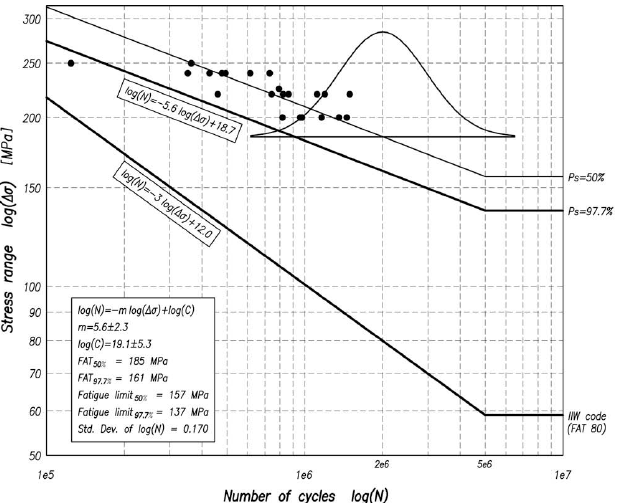
Figure 12. Experimental and design S–N curves [30]. Reprinted with permission from ref. [30]. Copyright 2021 Elsevier.